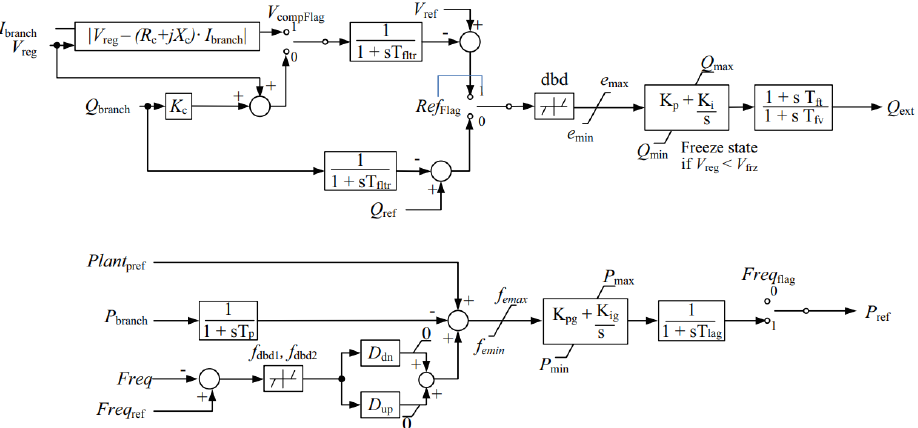
Figure 2. The REPC module control block diagram of a universal model of energy storage systems. Reprinted from Ref. [4] (Fig. 12), 2016, Xiaokang Xu. Table 1. Parameters of the REPC module.